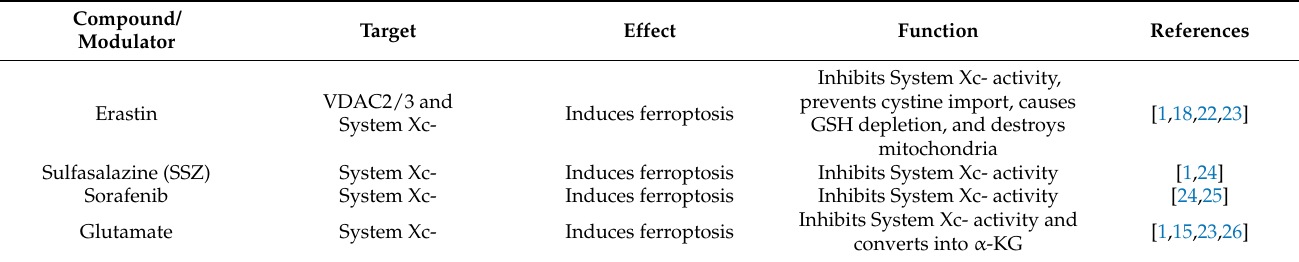
Table 1. Modulators involved in